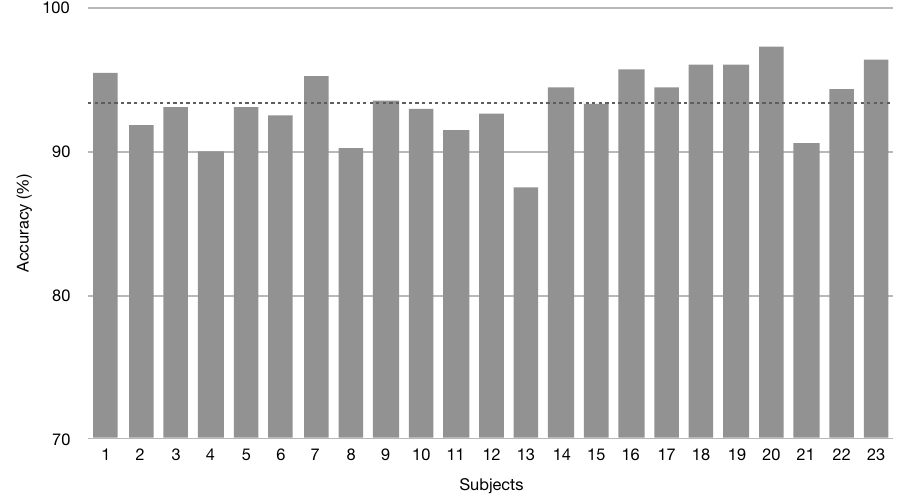
Figure 6. Classification accuracy over the 23 folds for the unlearned subjects (US